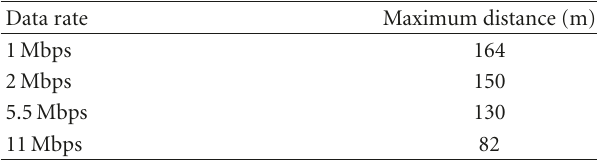
Figure 6: E ff ective throughput versus distance for CalRadio experiments. Table 1: CalRadio experiment data rates versus